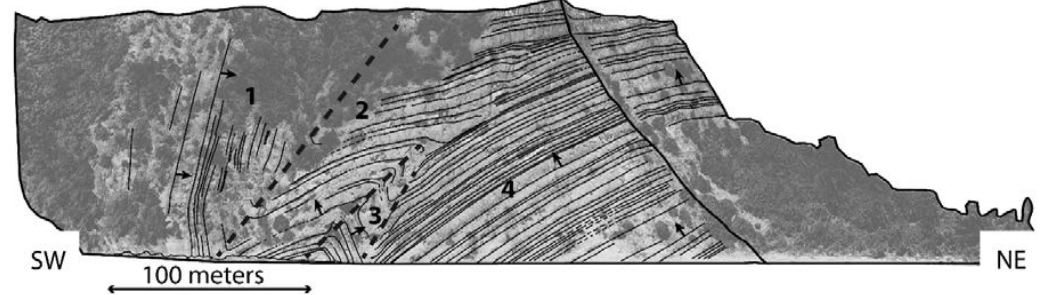
Figure 7. Structural interpretation of DOM 1 (see Figure 4a) projected on an orthorectified image. The view point of the orthorectified image is horizontal and sub-orthogonal to the mean slope direction. Beds (thin black lines) and the main traces of the fold axial planes (grey dashed lines) are shown. The numbers mark the 4 main fold limbs recognized by the preliminary visual analysis. Small black arrows show the polarity of the beds.